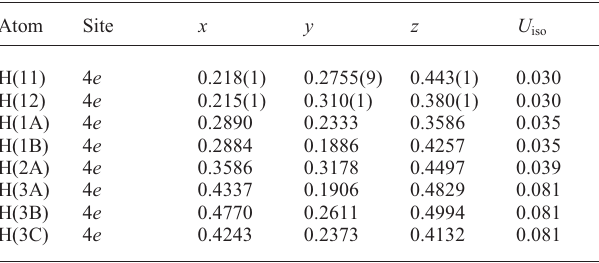
Table 2. Atomic coordinates and displacement parameters (in Å 2 )